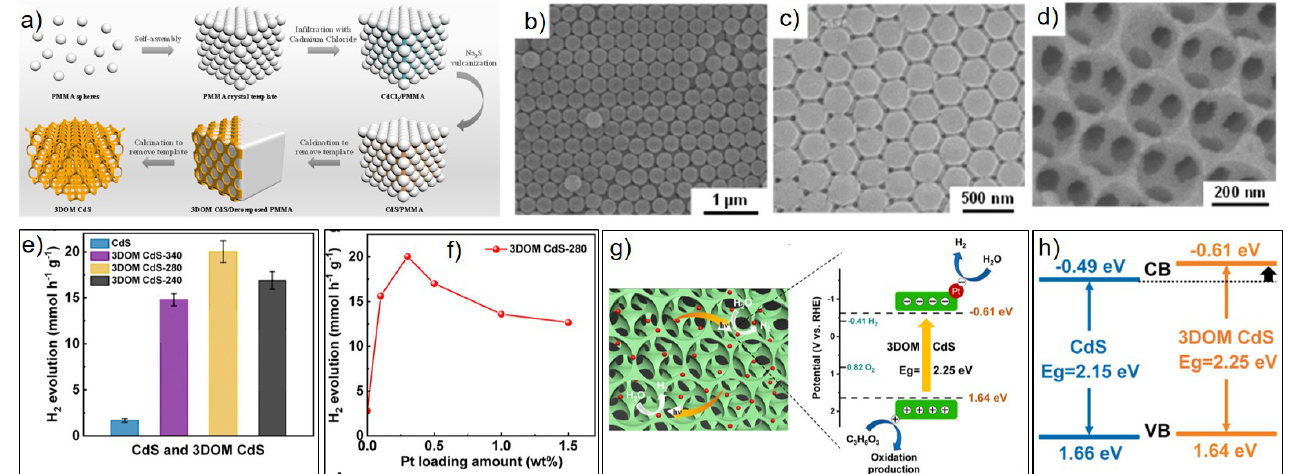
Figure 7. ( a ) Schematic illustration of the overall synthetic strategy of 3D ordered macroporous (3DOM) CdS. ( b ) PMMA crystal template. ( c ) PMMA/CdS. ( d ) 3DOM CdS. ( e ) HER efficiency over the CdS NPs and 3DOM CdS with 0.3 wt% Pt loading. ( f ) Efficiency of HER over the 3DOM CdS-280 with different Pt loadings. ( g ) Schematic illustration of 3DOM CdS for photocatalytic H 2 production. ( h ) Schematic illustration of the band gap states of CdS NPs and 3DOM CdS. [57] Copyright